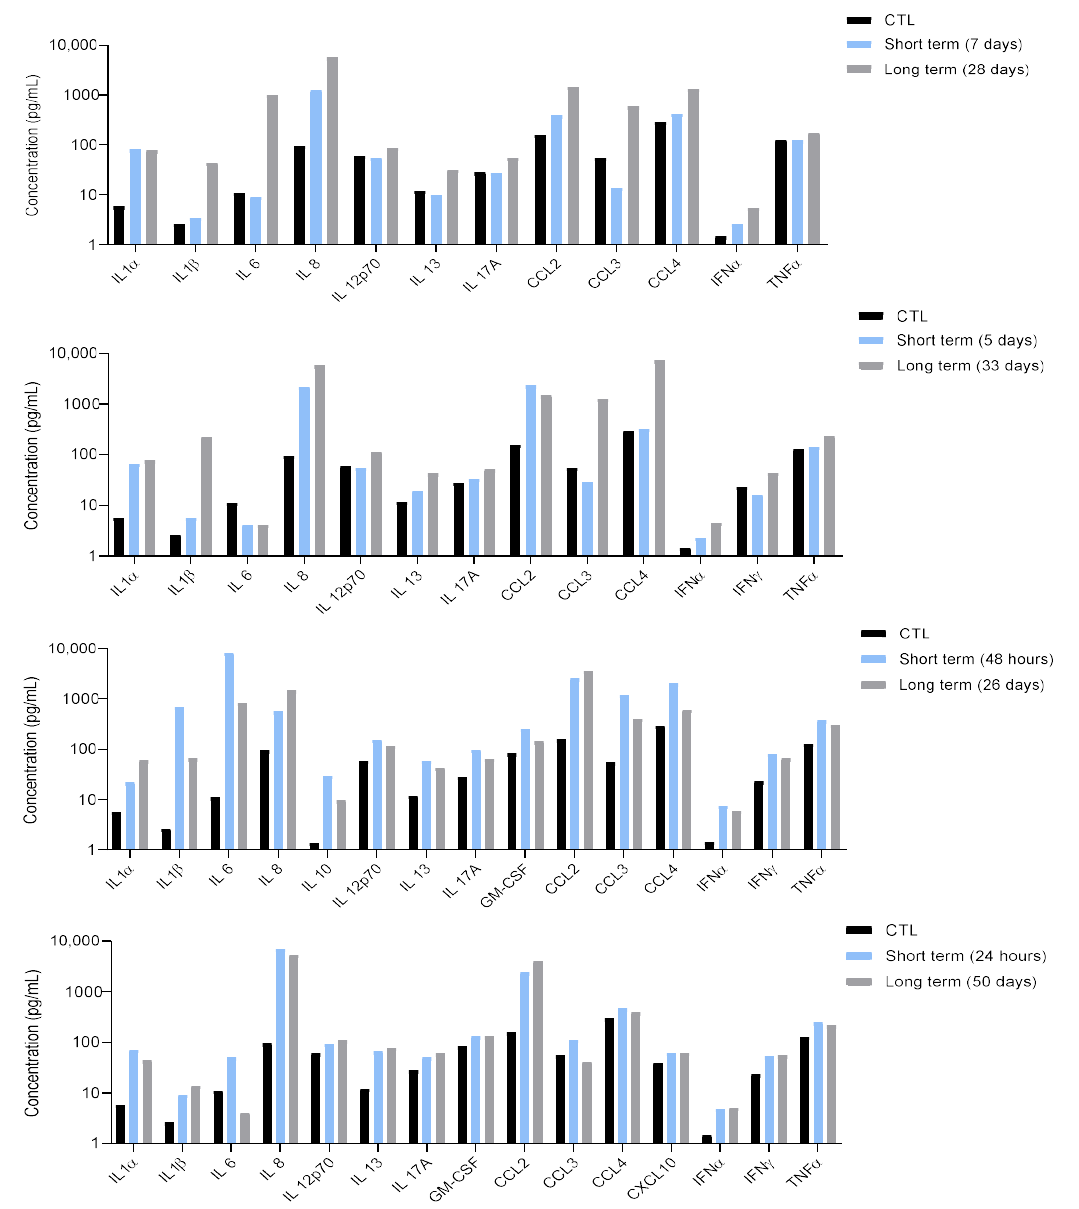
Figure A3. Examples of patients with persistent inflammation. Plasma concentration in pg/mL of different pro-inflammatory markers of non-infected CTL (black), WNND-short term (blue), and WNND-long term (grey) humans, measured by multiplex bead-based ELISA. Bars show value.